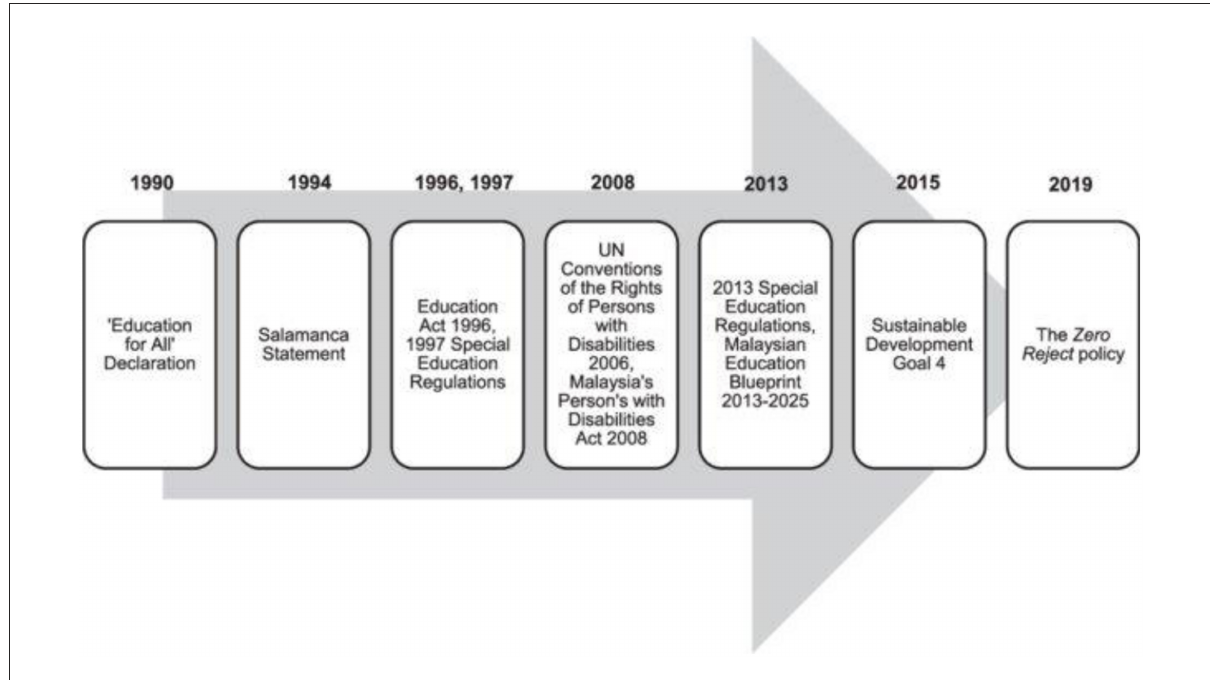
FIGURE1 The evolution of inclusive education in Malaysia. Ref. Chin